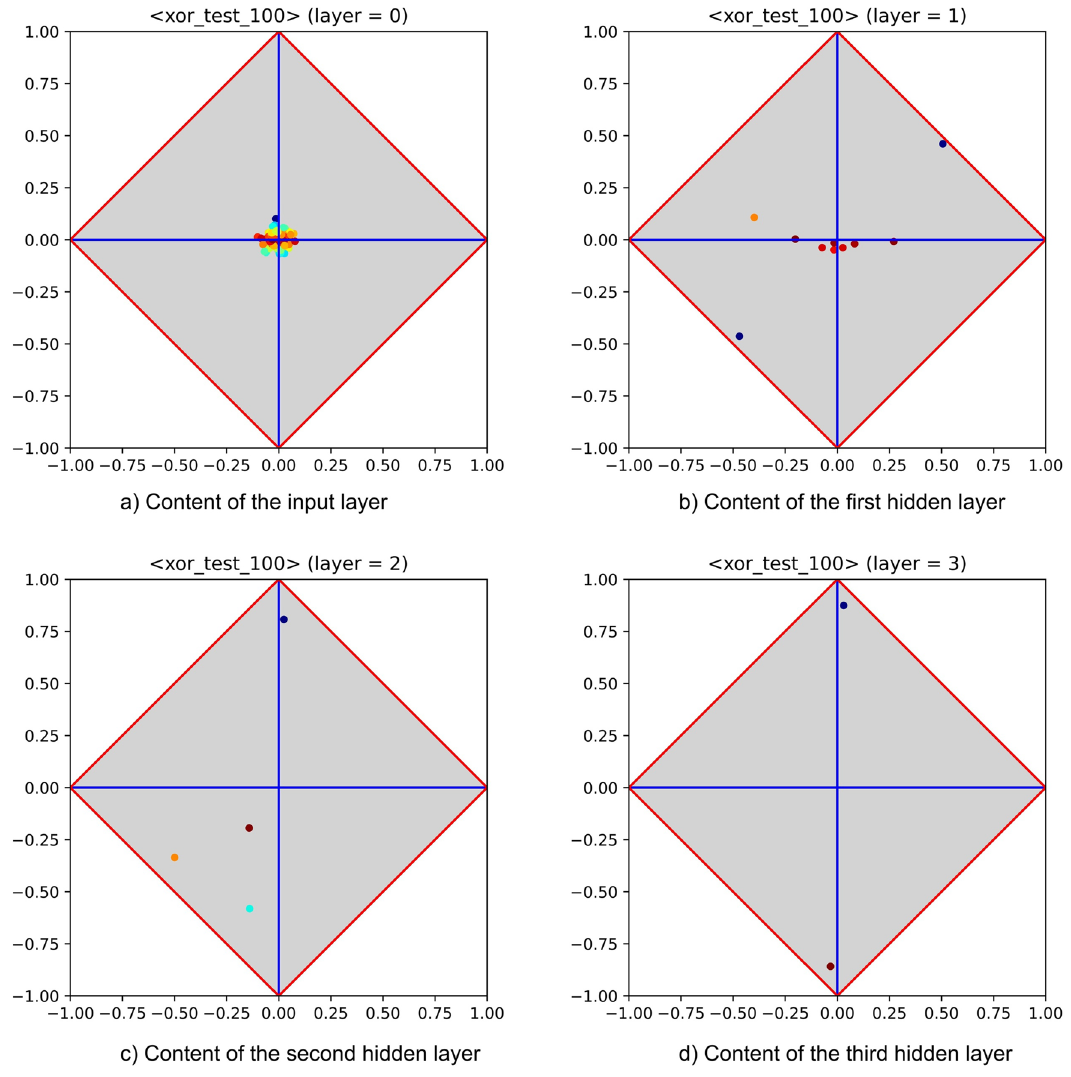
Figure 8. Feature extraction performed by an MLP equipped with three hidden layers (with 10, 4, and 2 neurons) and trained with PT on the synthetic xor dataset. The sequence highlights the role of feature